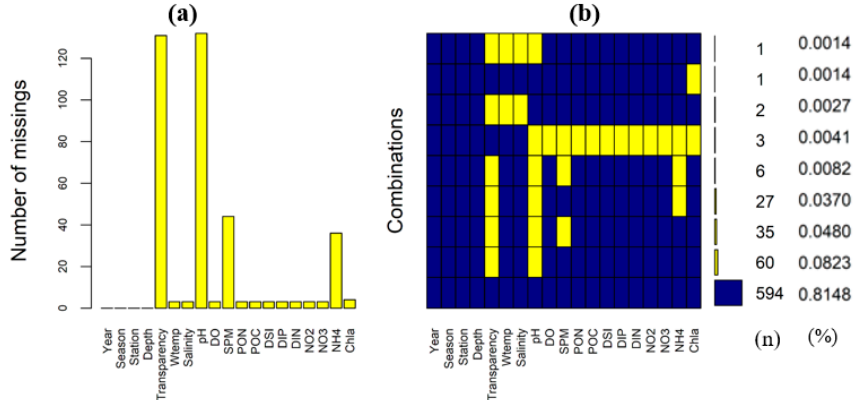
Figure 4. Missing data pattern of surface data ( n = 729). Number of missings ( a ); Combinations ( b ).